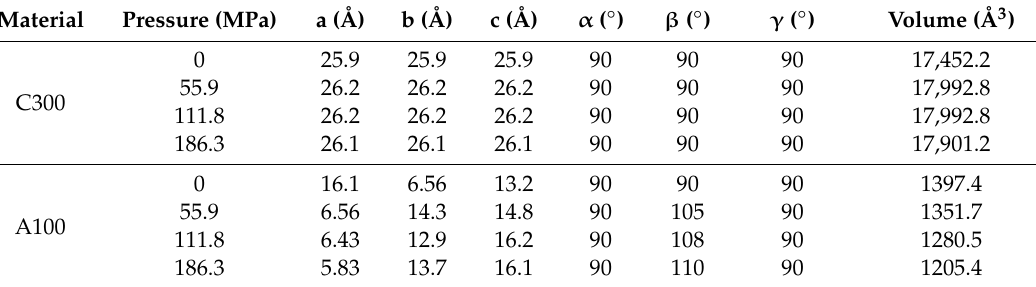
Table 3. Cell total volume and lattice parameters for each structure depending on applied